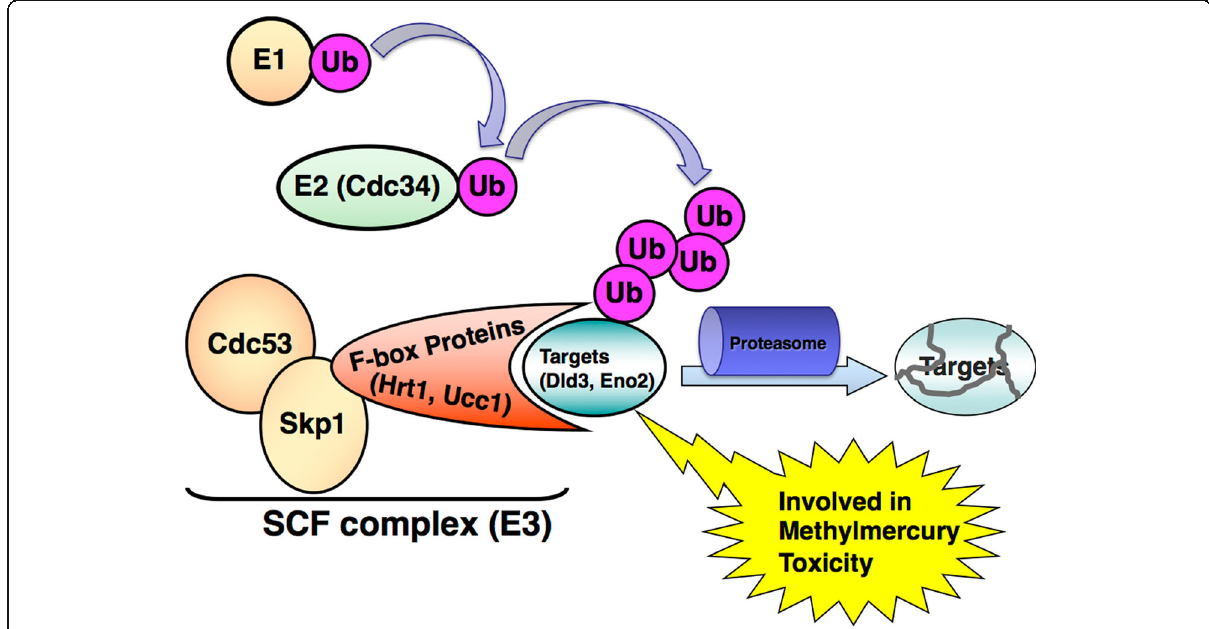
Fig. 1 The ubiquitin-proteasome system involved in methylmercury toxicity. The target proteins, Dld3 and Eno2, respectively specific to Hrt1 and Ucc1 enhance methylmercury toxicity, unless they are degraded by ubiquitin-proteasome system. E1, ubiquitin activating enzyme; E2, ubiquitin conjugating enzyme; E3, ubiquitin ligase; Ub,